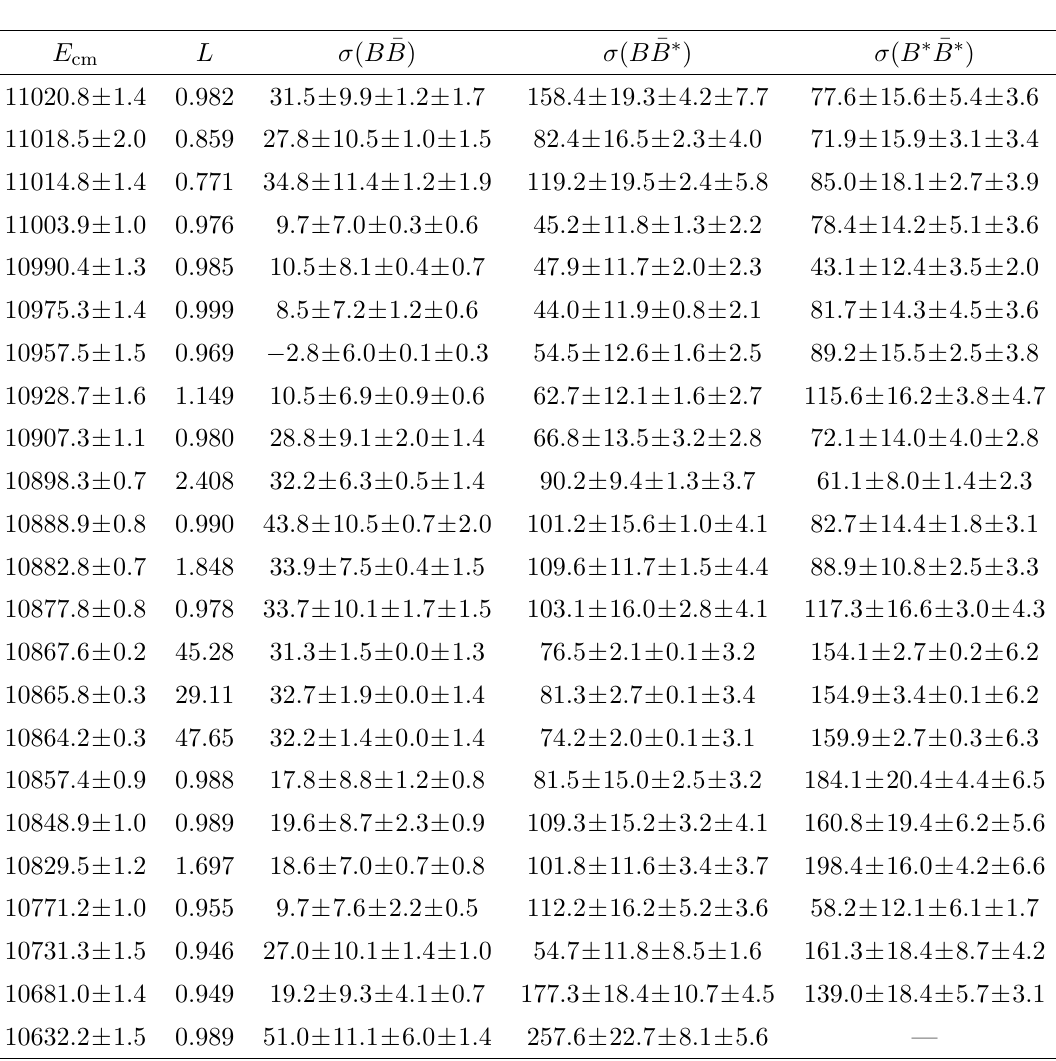
Table 5 . Energies (in MeV ), luminosities (in fb − 1 ) for various data samples and the results for the dressed cross sections (in pb). The first error in the cross section is statistical, the second is uncorrelated systematic, and the third is correlated